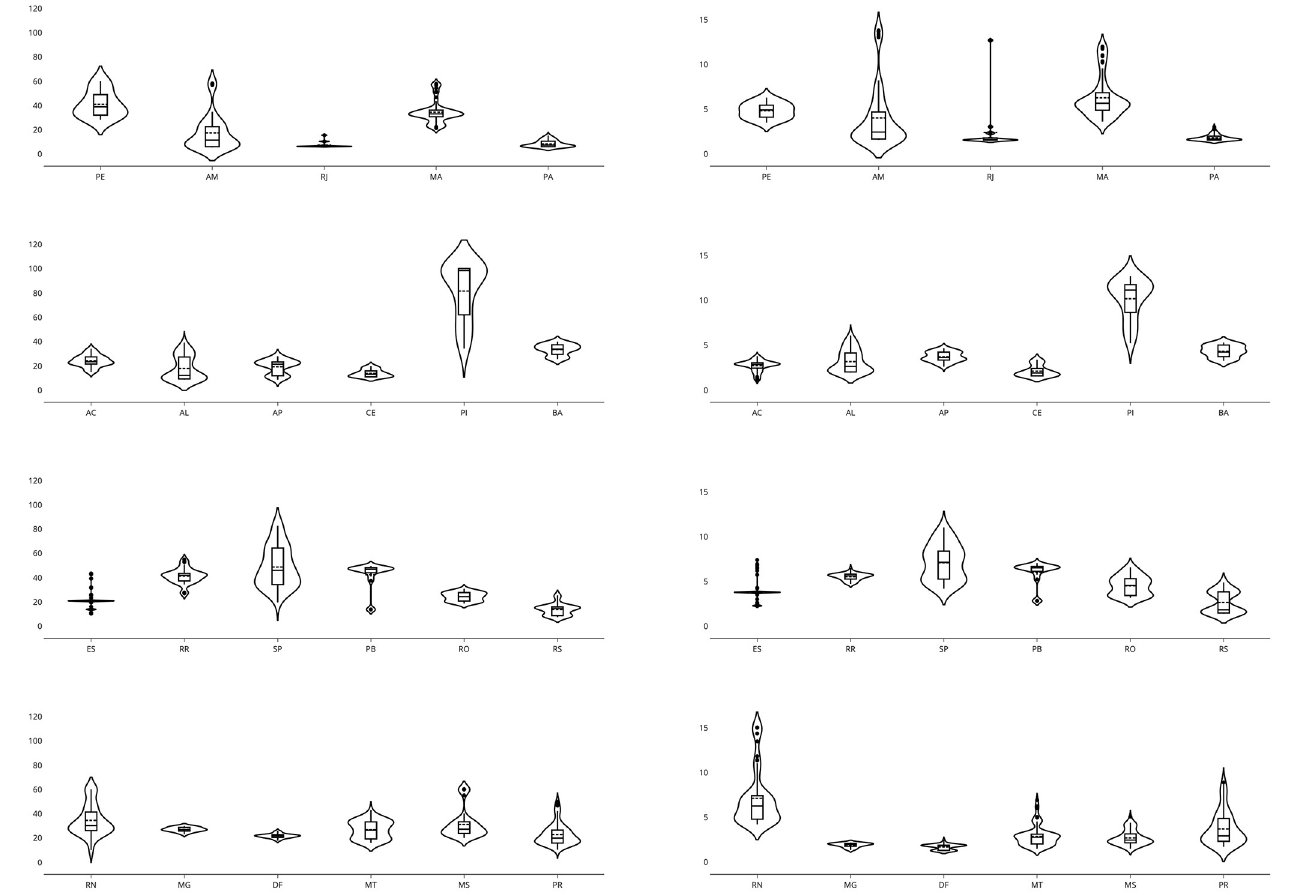
Fig 6. Distributions of the estimated parameters D , R 0 , μ and λ , for all Brazilian states based on the state that presented the first peak. (a) Distribution of the estimated recovery rate in days: − D − � X